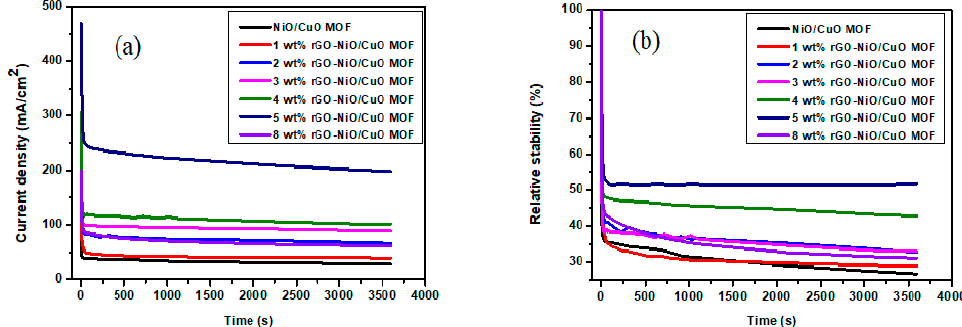
Figure 9. ( a ) Chronoamperometry curves ( b ) relative stability curves of NiO / CuO MOF and its composites with, 1–5 wt% and 8 wt% rGO–NiO / CuO MOF in 3 M methanol and 1 M NaOH at 50 mV /